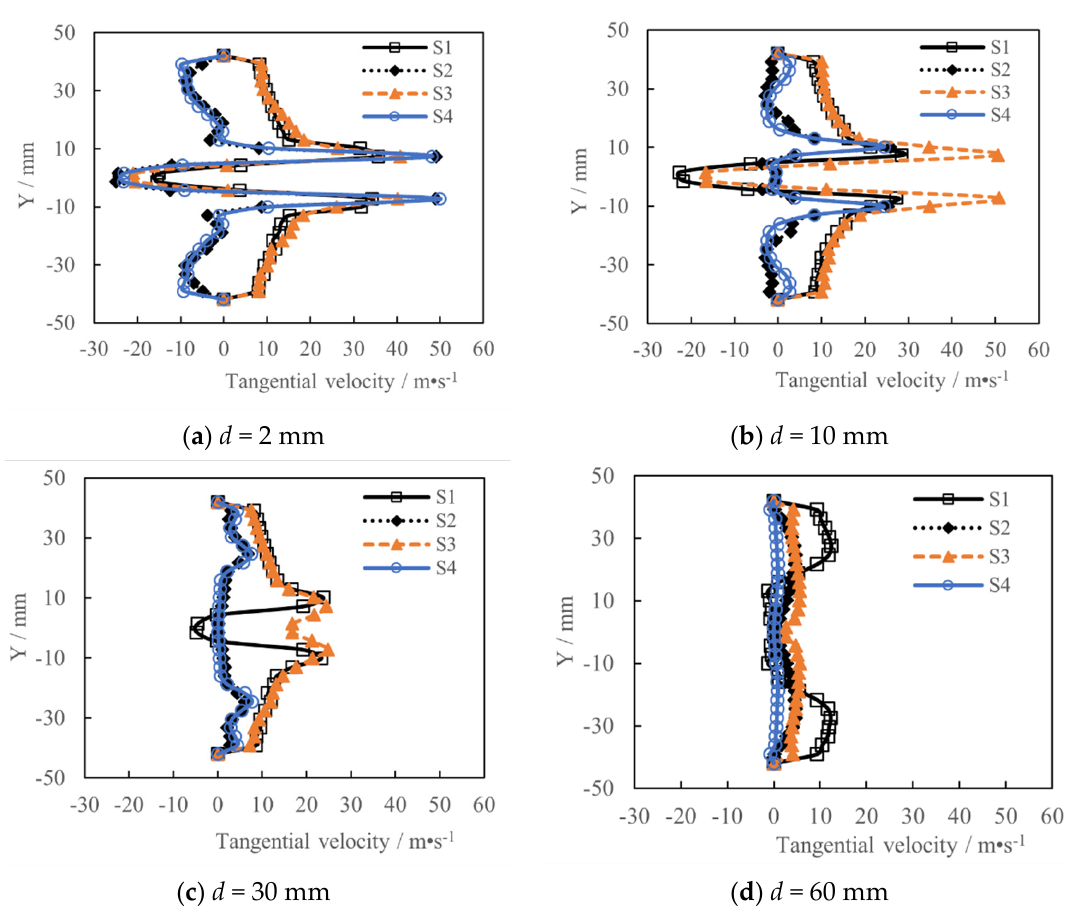
Figure 9. Radial profile of tangential velocity at different axial sections.